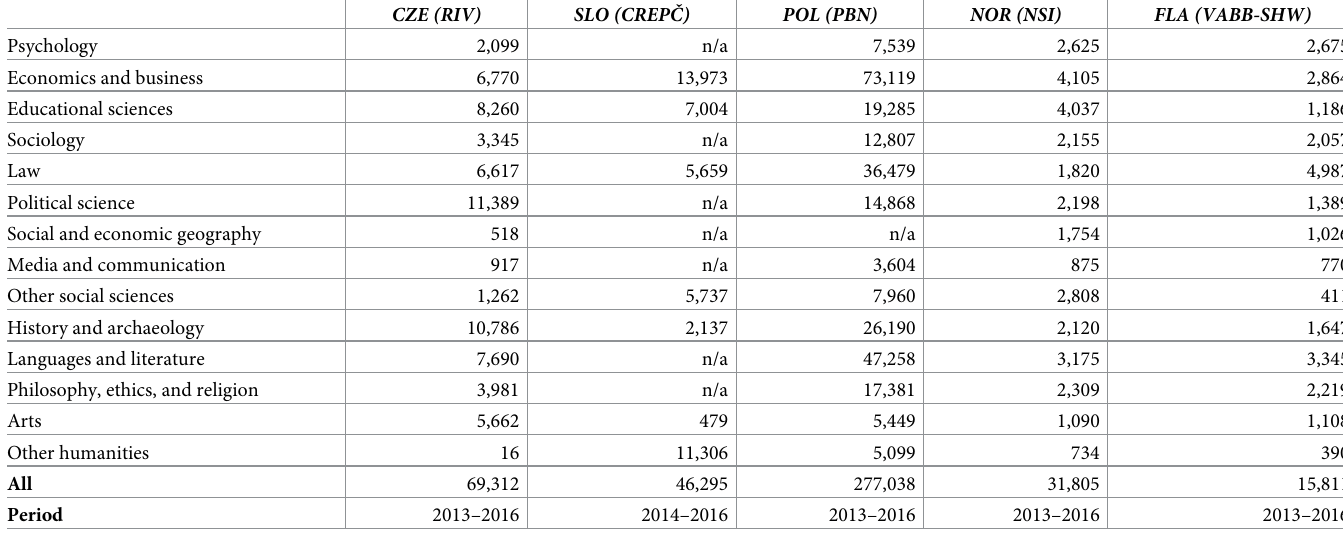
Table 1. The total volume of all types of SSH publications in national databases.